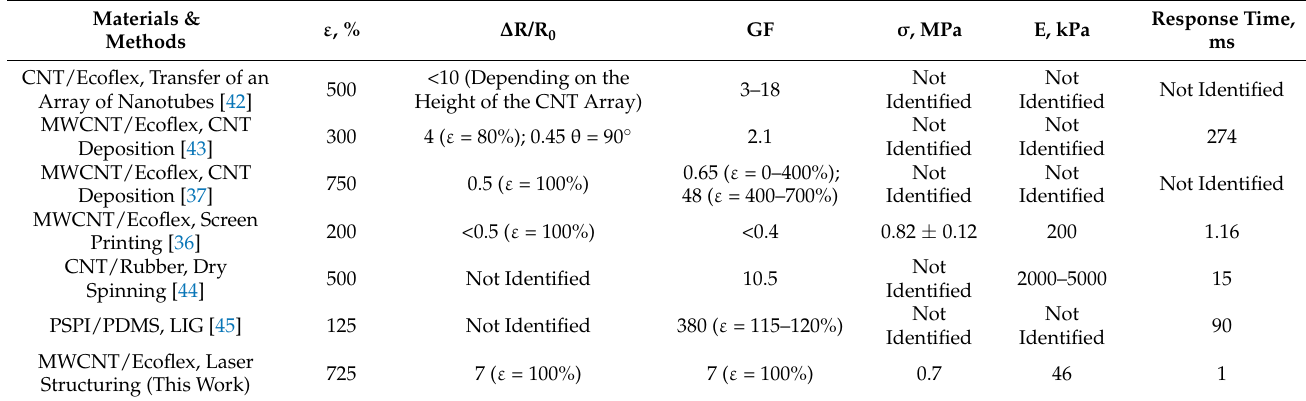
Table 1. Comparison of the characteristics of the MWCNT/Ecoflex strain sensors with sensors manufactured by other